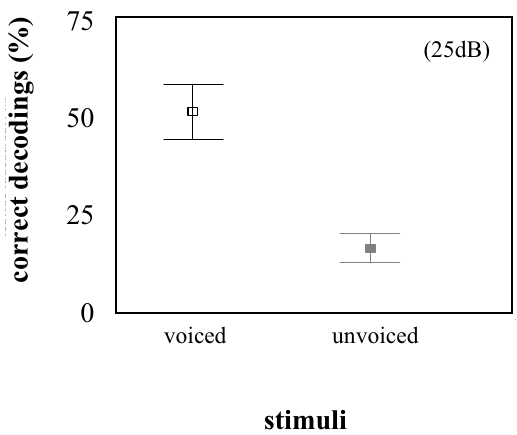
Fig. 4 – Percentage of correctly decoded stimuli plotted against stimulus quality (median and interquartiles); i.e. voiced (= phonated) numbers (left), or unvoiced (= whispered) numbers (right). The two squares refer to stimuli presented through head- phones with an amplitude of about 25